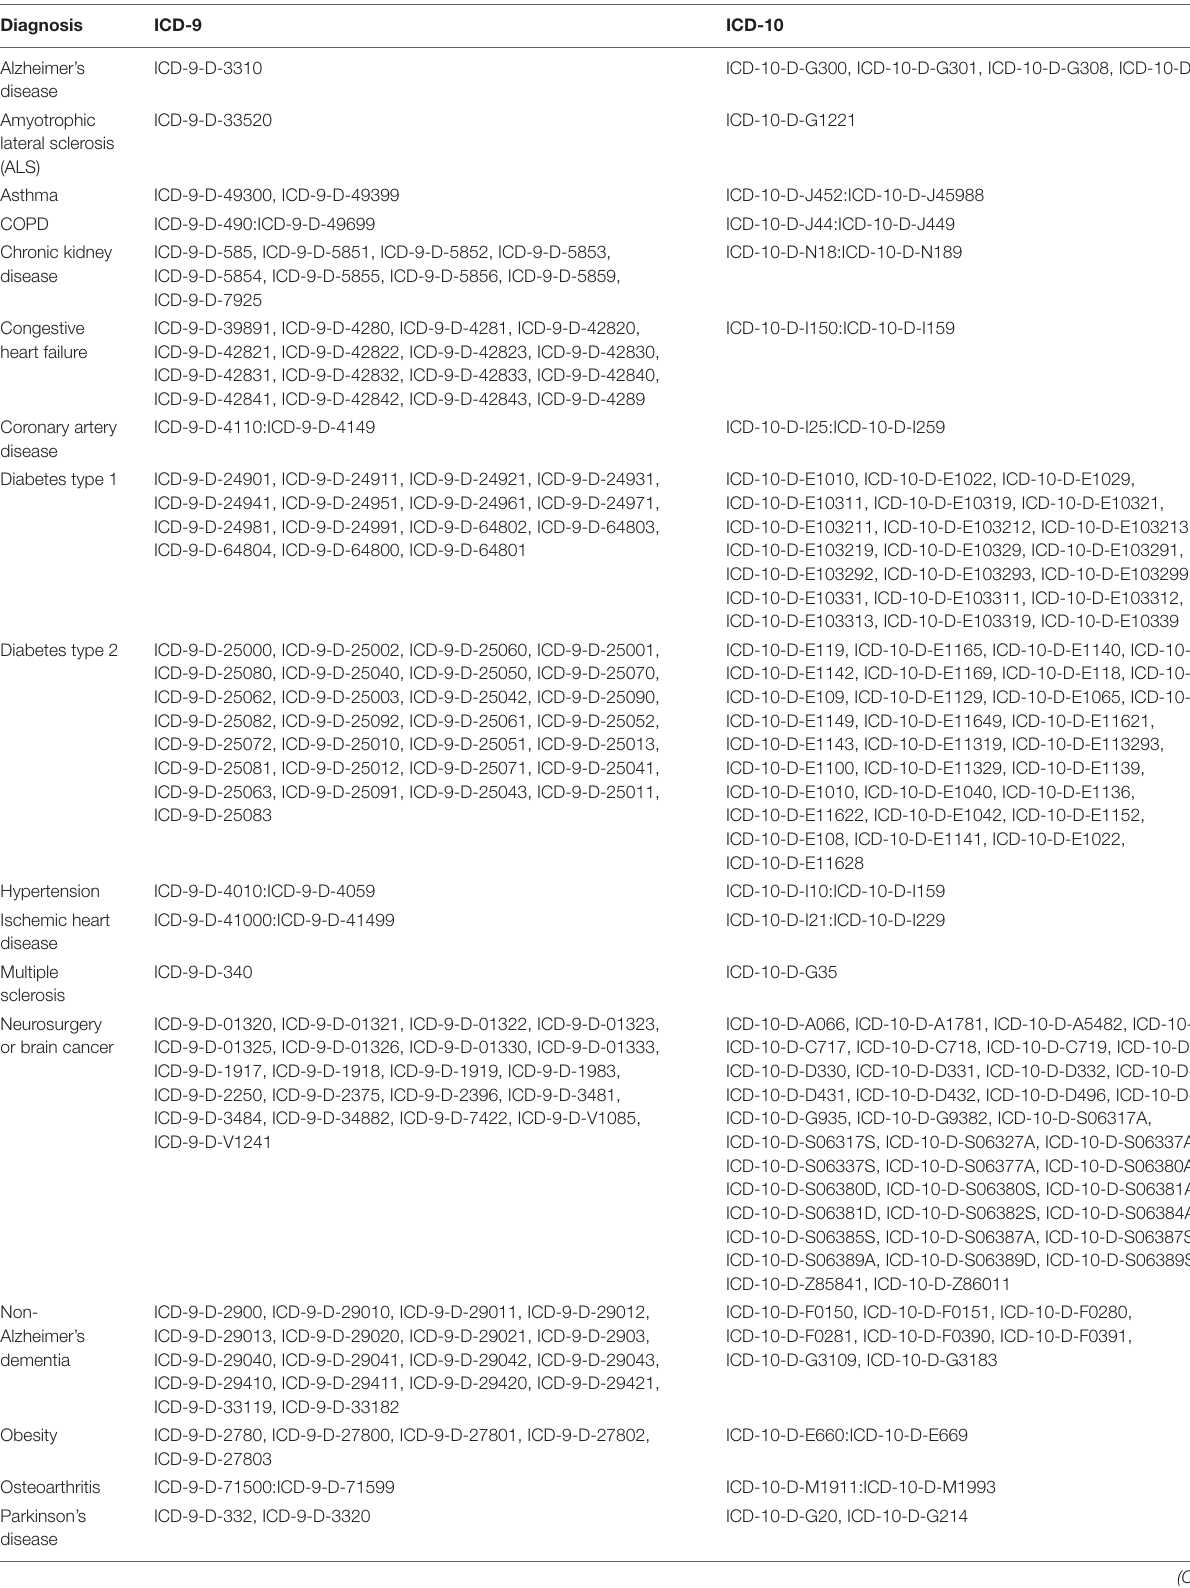
TABLE 2 | List of diagnose codes